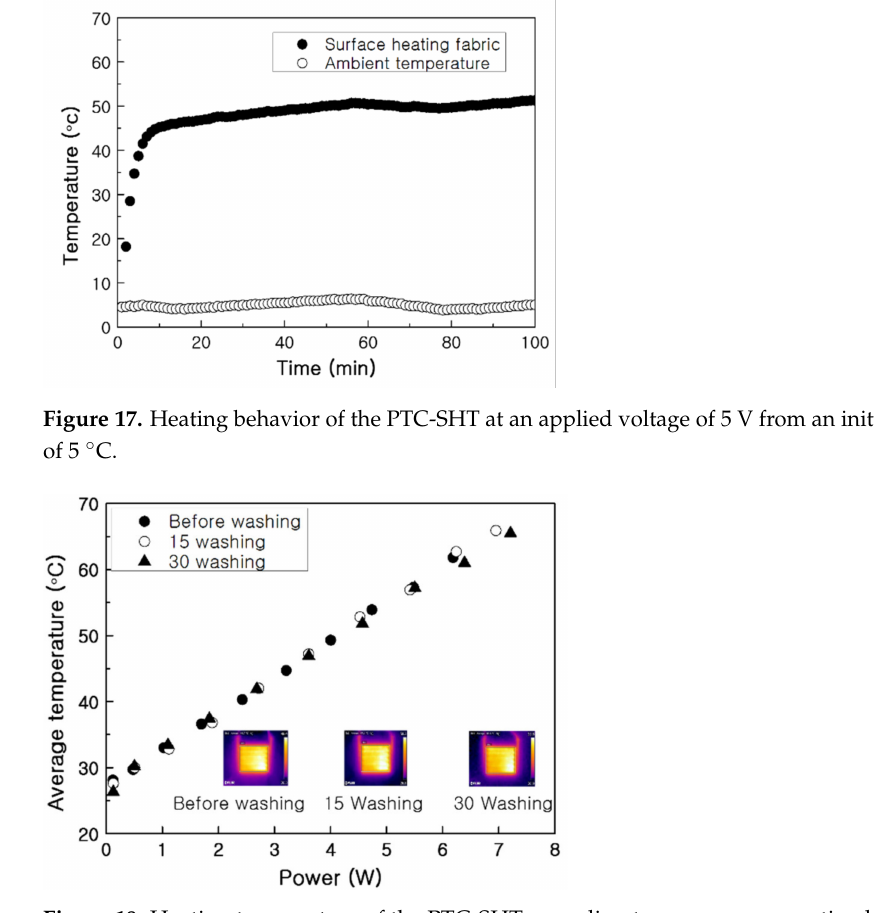
Figure 18. Heating temperature of the PTC-SHT according to power consumption before and after washing (inserts: thermal images at an applied voltage of 3 V).